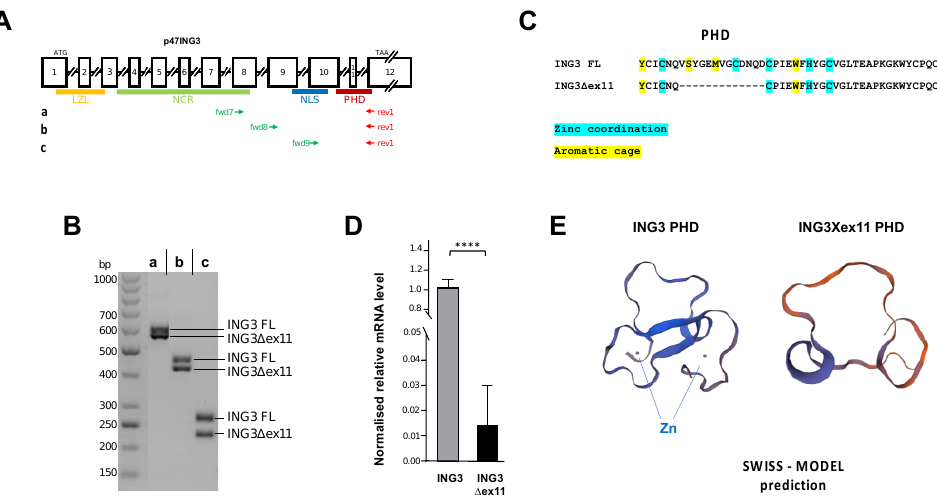
Figure 1. Identification of a novel ING3 splice variant lacking the PHD. Total mRNA from LNCaP cells were analysed with a set of primers for ING3 splice variants. ( A ) Intron exon structure of ING3 with the indicated protein domains, LZL, leucine zipper-like; NCR, novel conserved region; NLS, nuclear localisation signal; and PHD, plant homeodomain. ( B ) Agarose gel reveals two PCR products by each indicated primer set. ( C ) Cloning and sequencing of the lower migrating band indicates the lack of exon 11 of ING3 with an in-frame fusion between exon 10 and 12. ( D ) Patient samples (n = 6) obtained from prostatectomies were analysed for the presence of ING3 and ING3 ∆ ex11 mRNA. One-tailed and two-tailed unpaired t -test showed same significance. ( E ) Predicted structure of ING3 and ING3 ∆ ex11 protein by Expasy SWISS-MODEL indicates the lack of Zn 2+ ion binding in the PHD and an aberrant folded PHD. p value < 0.0001 (****).